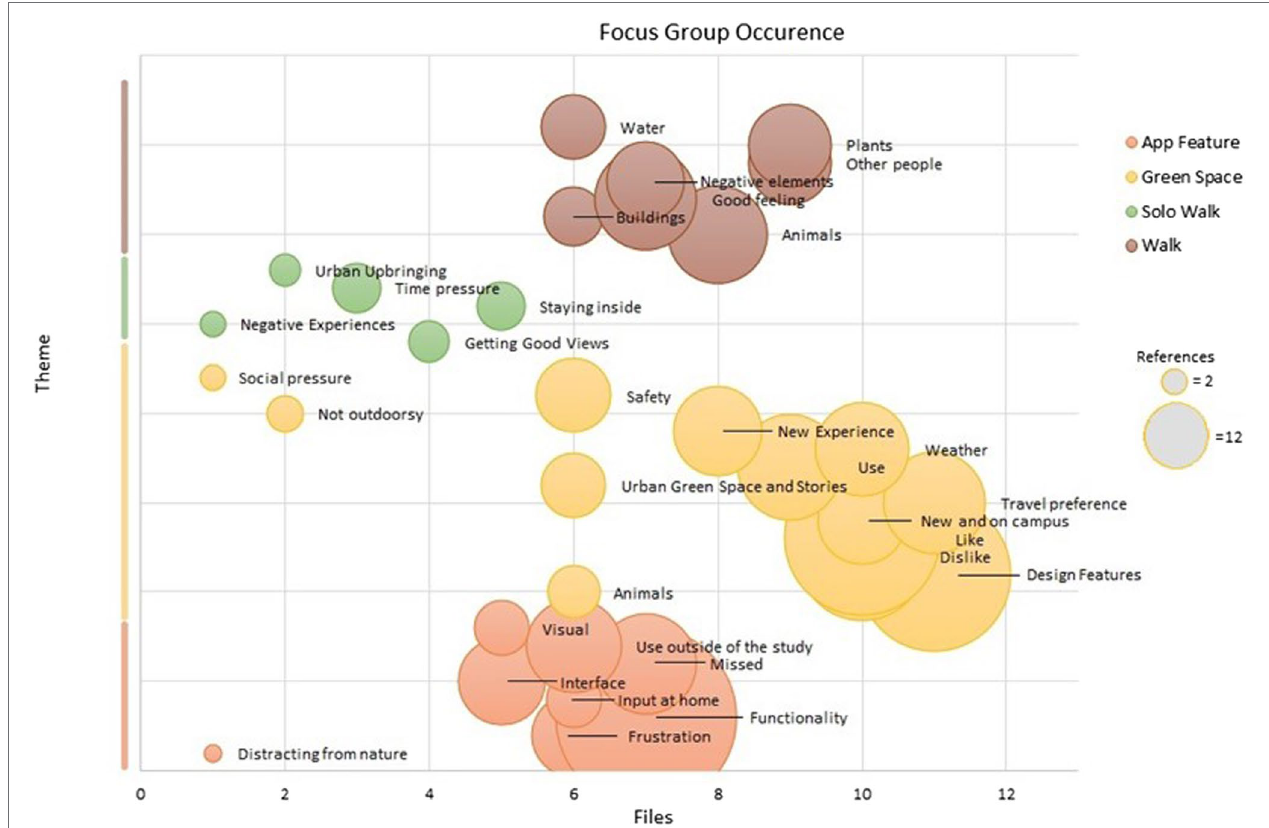
FIGURE 5 | Focus group theme